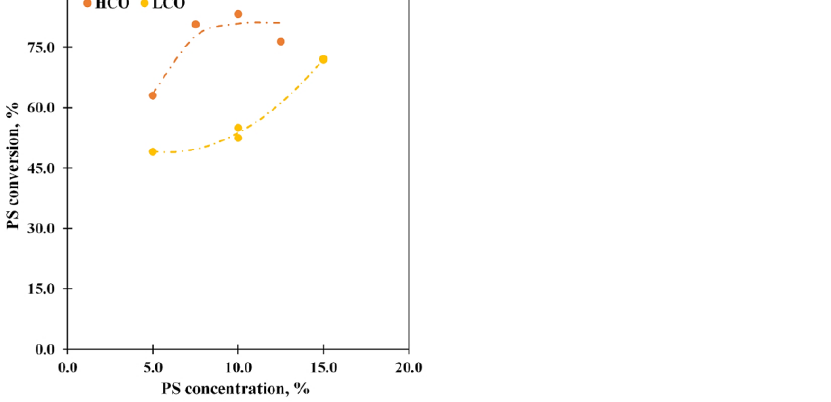
◦ C and WHSV 85 h − 1 .